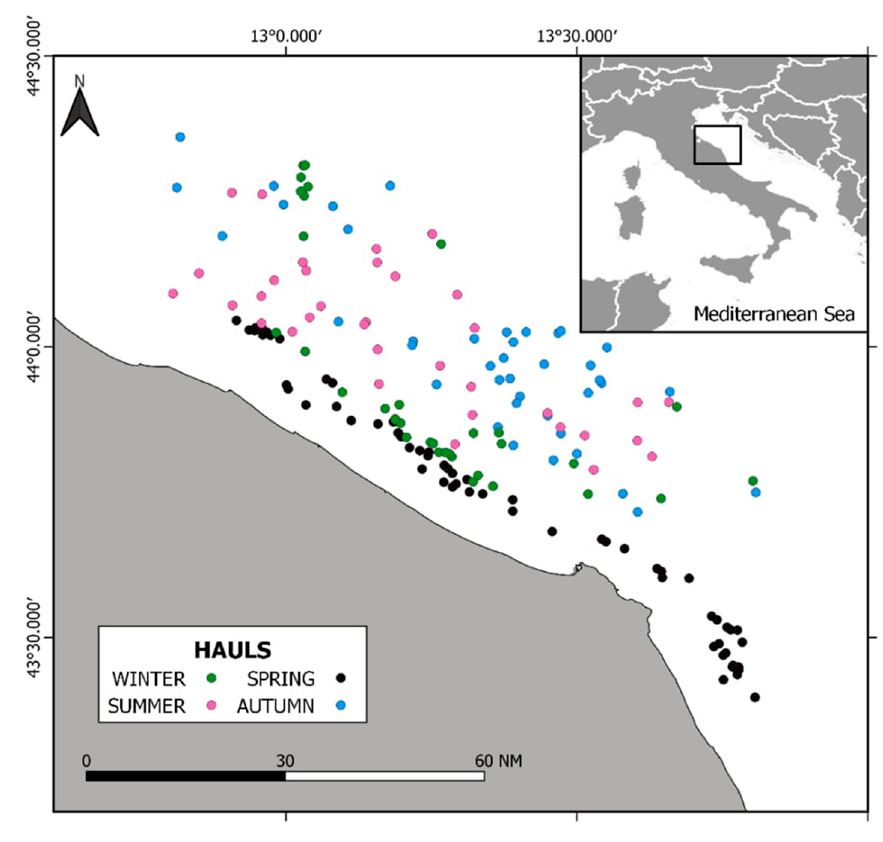
Figure 1. Sampling locations for a study of Solea solea diets in the Central Adriatic Sea in 2019.